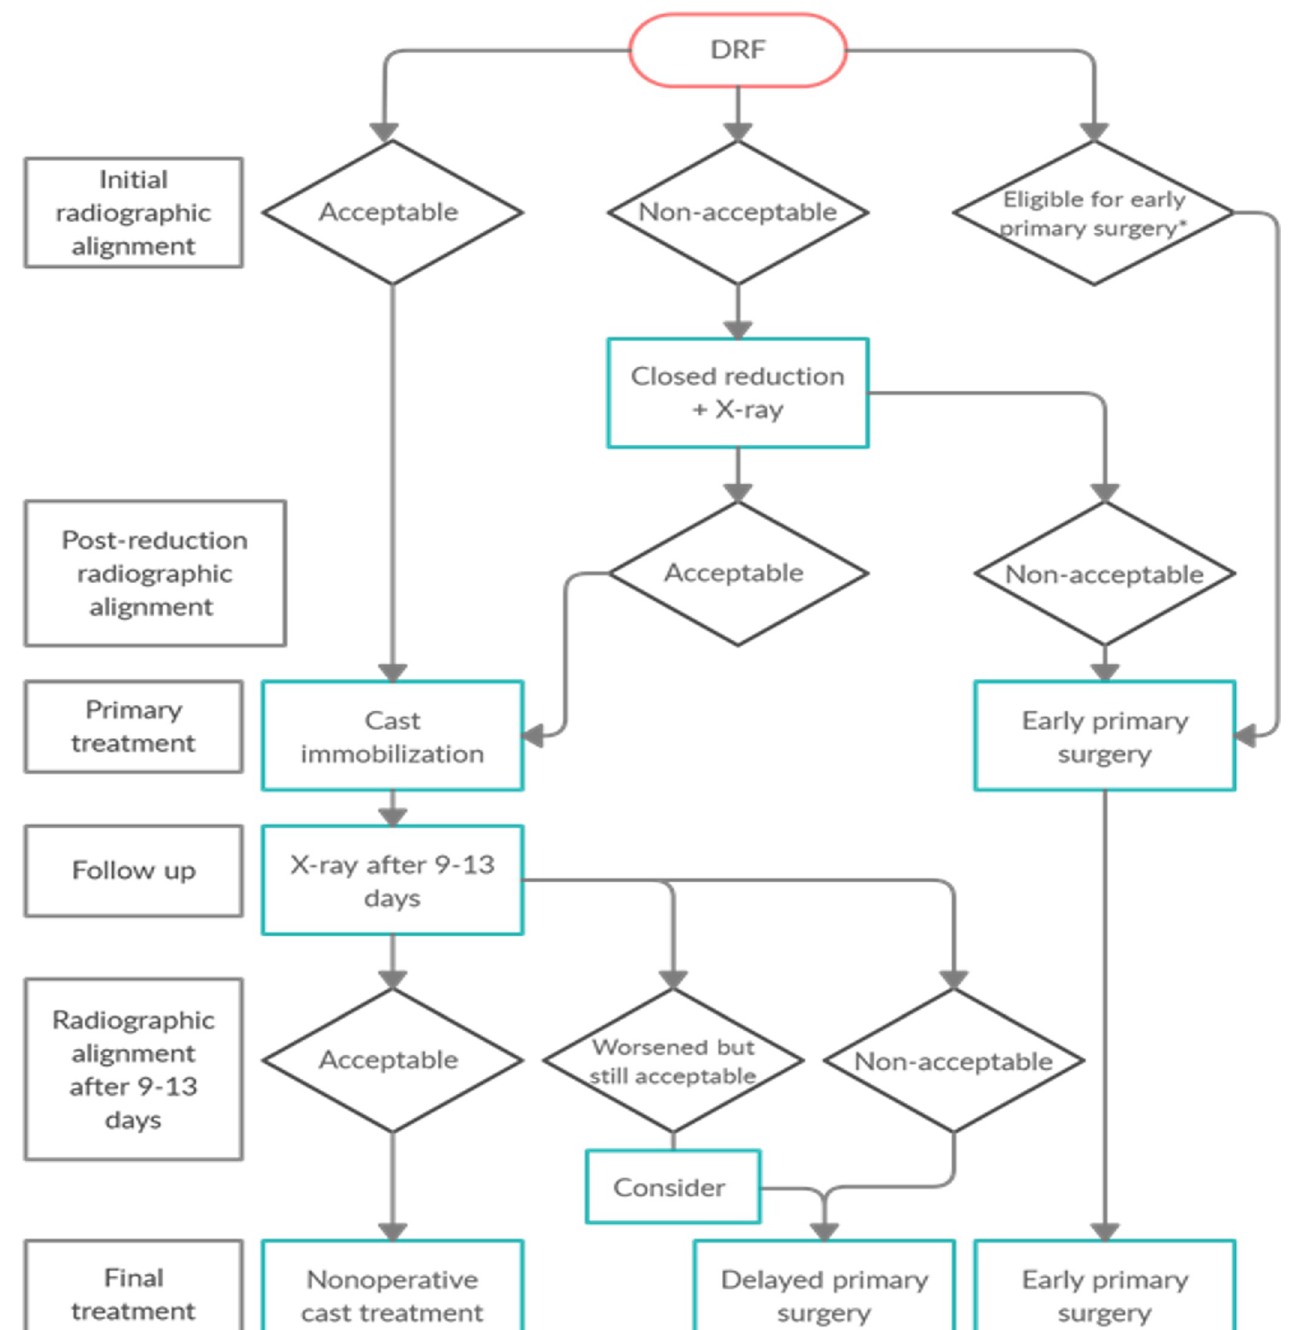
Fig 2. Flow chart for treatment suggested in the Swedish national treatment guidelines for distal radius fractures (DRF). � According to the 4 defined subgroups (fast-tracks) analyzed in the present study.